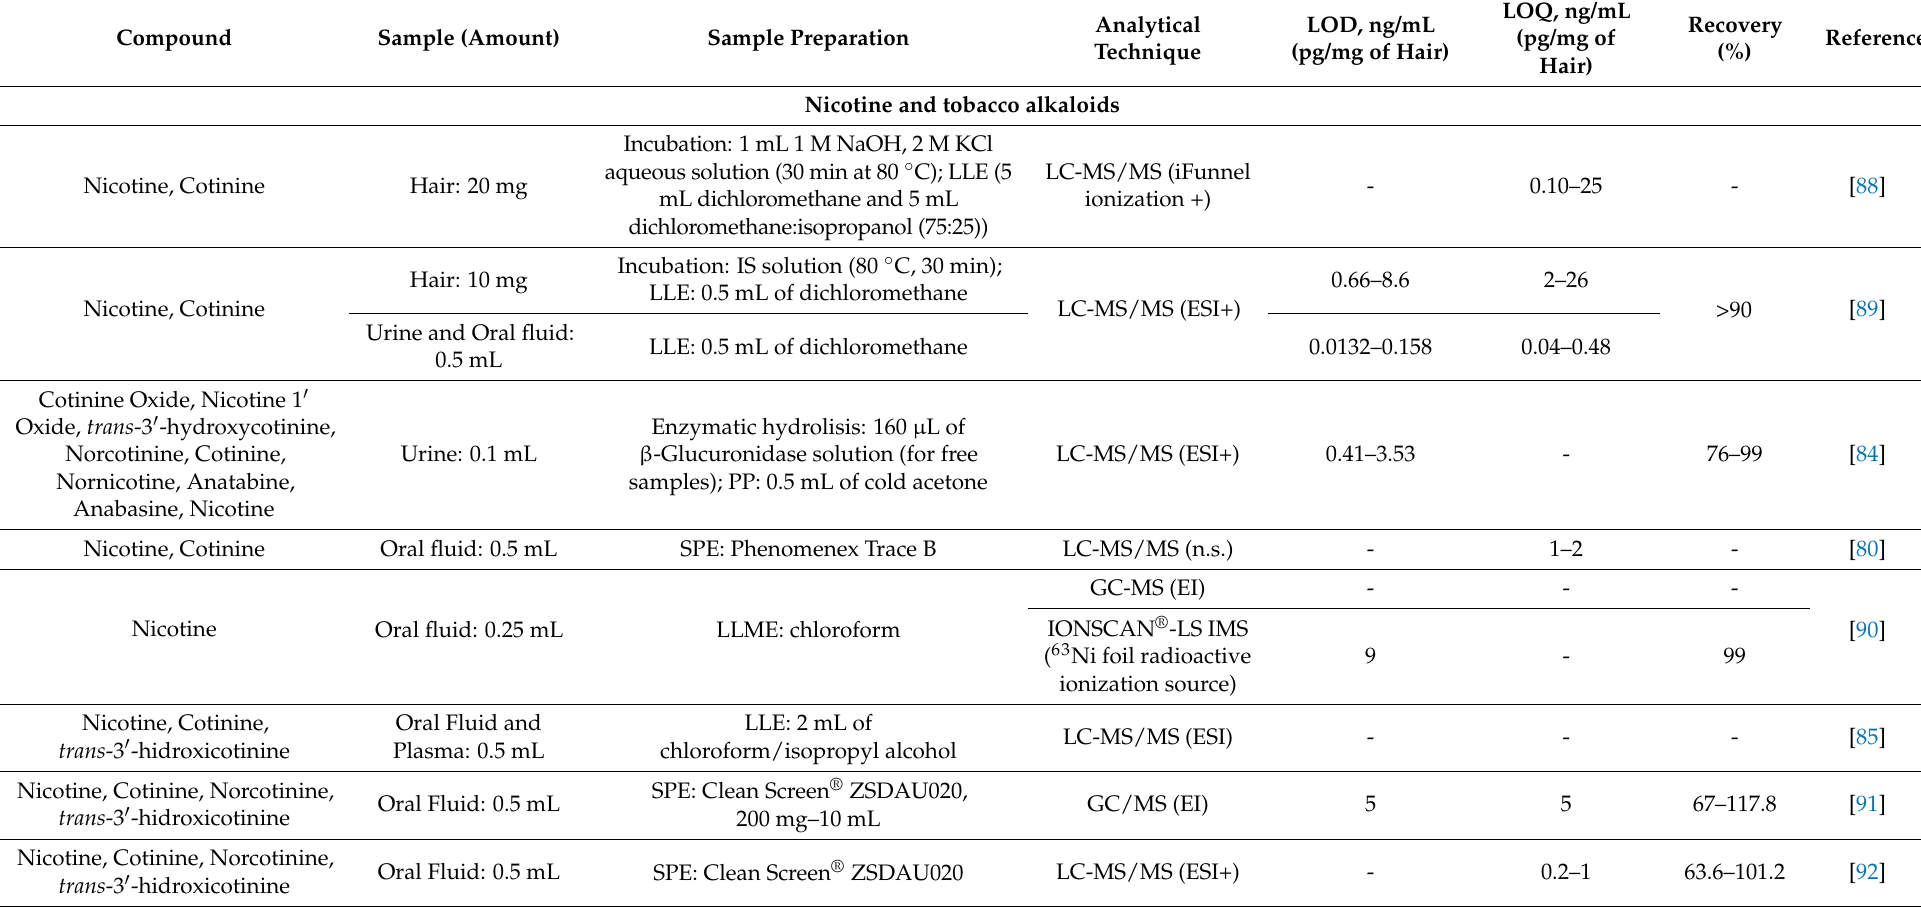
Table 1. Sample preparation and analytical methods to determine biomarkers of exposure to environmental tobacco smoke (ETS) in biological